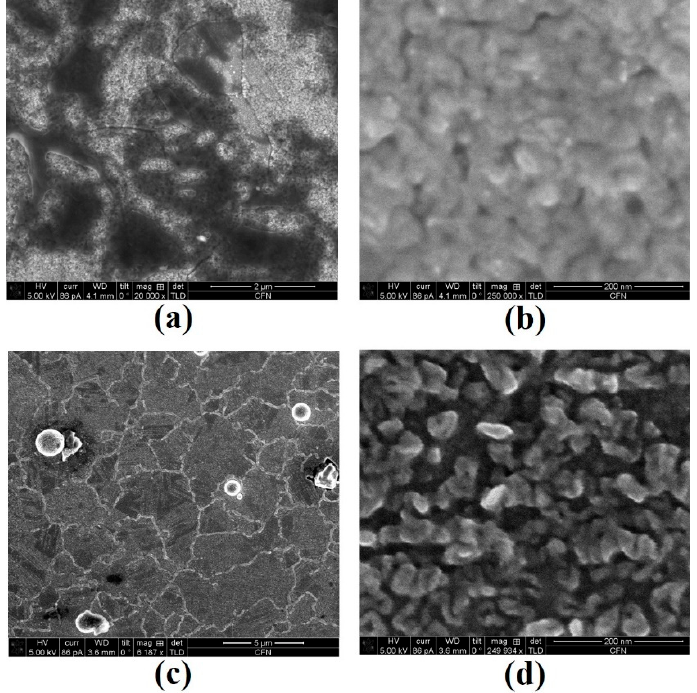
Figure A2. ( a ) SEM image of a carbon film grown on the copper (Cu) foil substrate; ( b ) SEM image of an enlarged view of the carbon film grown on the copper (Cu) foil substrate; ( c ) SEM image of a carbon film grown on the Cu-thin-film-covered silicon substrate; ( d ) SEM image of an enlarged view of the carbon film grown on the Cu-thin-film-covered silicon substrate.